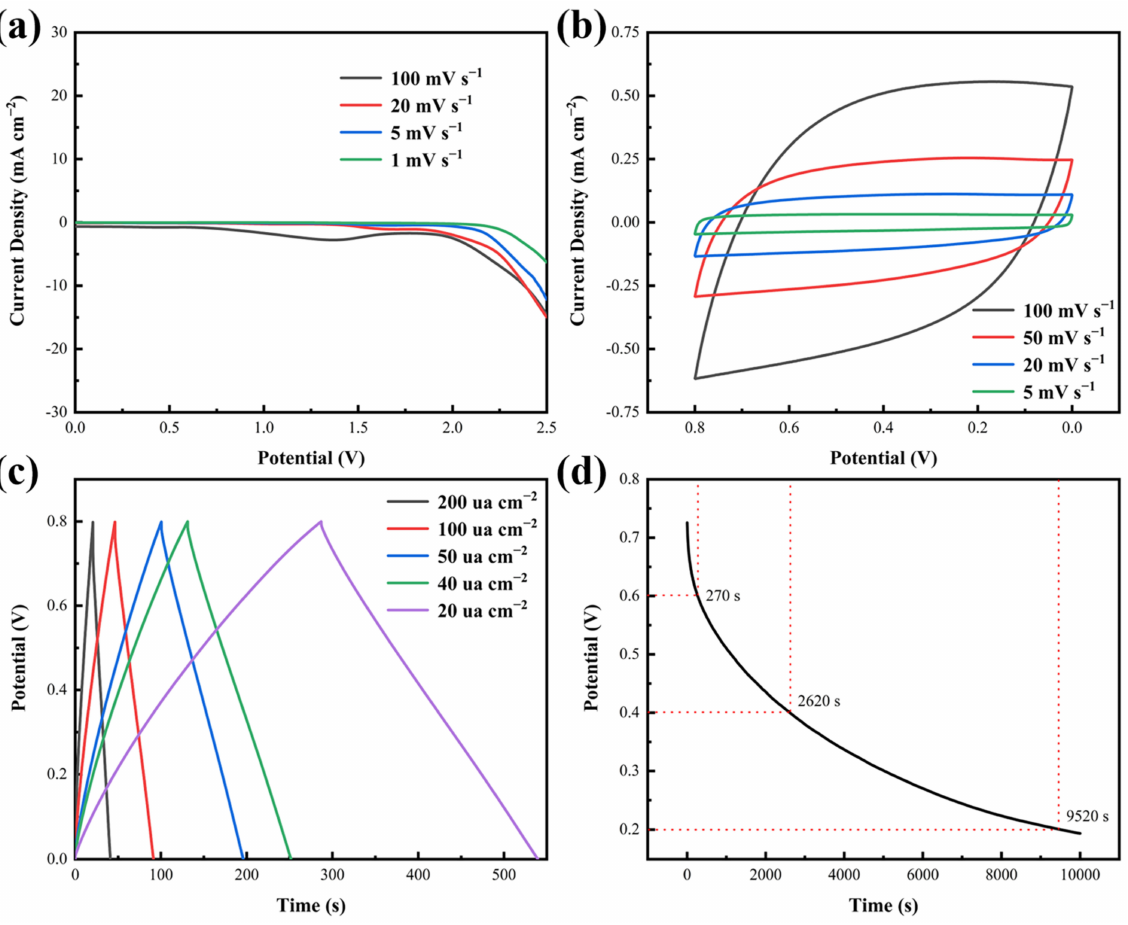
Figure 7. ( a ) LSV curves of the BPVA-Pluronic hydrogel electrolytes at various scan rates. ( b ) CV curves of the MSC at various scan rates. ( c ) GCD curves of the MSC at current densities. ( d ) Self-discharge curve of the